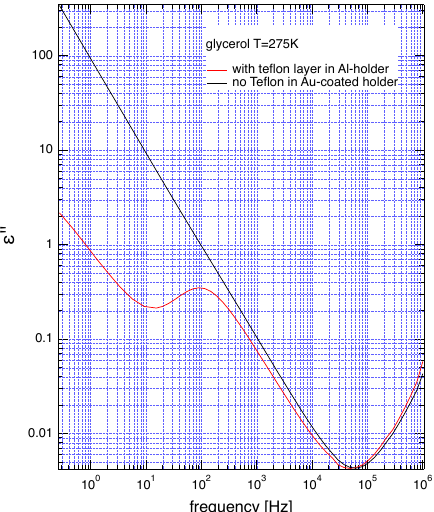
Figure 5. Temperature dependence of the dielectric permittivity of glycerol at selected frequencies measured in step heating.